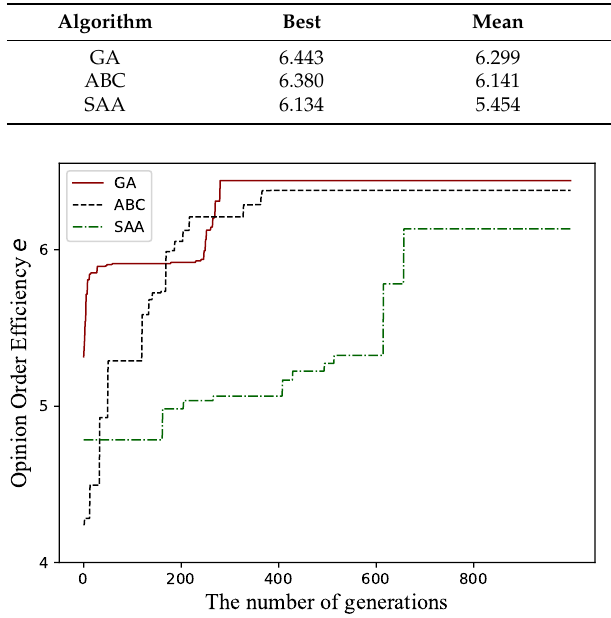
Table 6. Comparative results of GA, ABC and SAA.